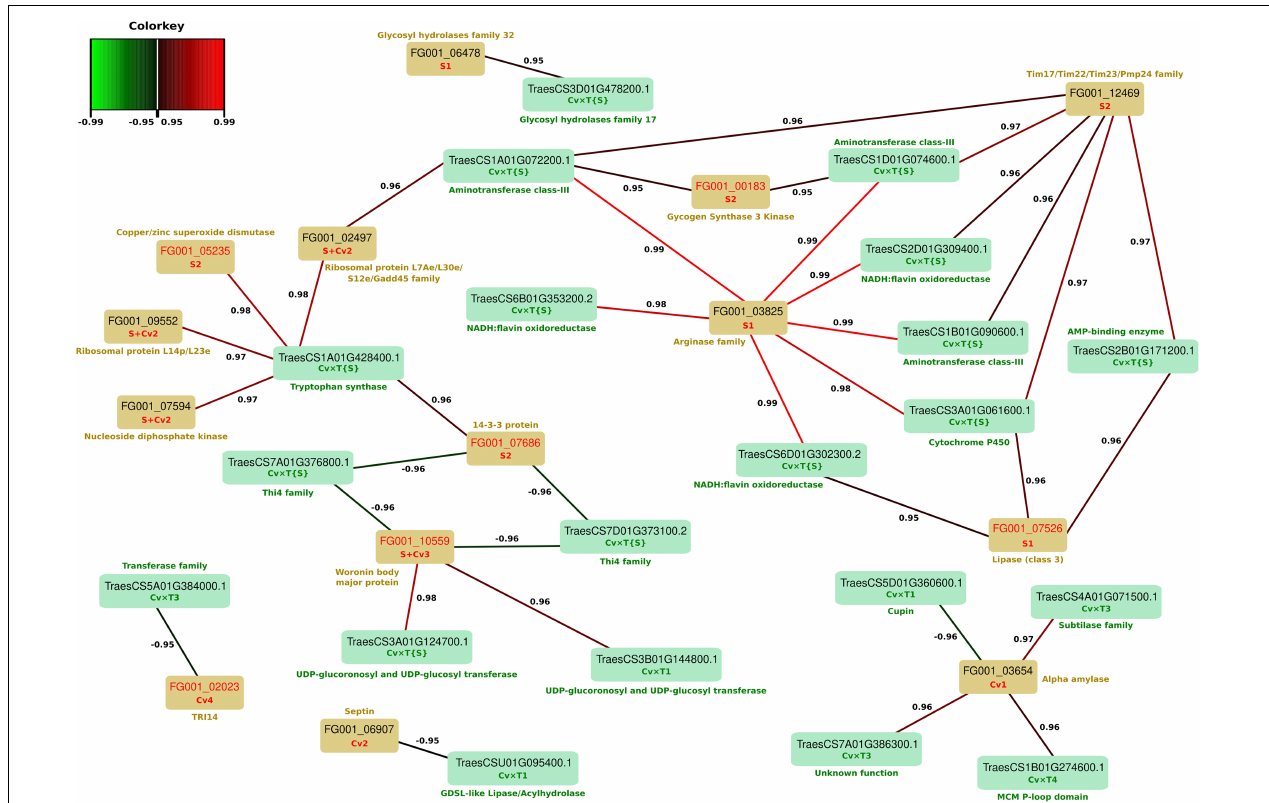
FIGURE 7 | Network plot outlining regularized generalized canonical correlation analysis (rCCA)-derived correlations from wheat proteins and Fusarium graminearum putative effectors. Wheat and F. graminearum protein accessions are indicated in the green and yellow rectangles , respectively. F. graminearum red accessions highlight the proteins described in the literature to be involved in fungal pathogenicity. For each protein included in the network, the cluster reflecting its pattern of abundance variation is indicated in green for wheat proteins and in red for F. graminearum proteins according to Fabre et al. (2019a). The canonical correlation coefficient derived from the rCCA is represented as a line between each of the proteins (negative correlations less than –0.95 in green and positive correlations > 0.95 in red ). Predicted protein functions are indicated in green and yellow for wheat and F. graminearum proteins,